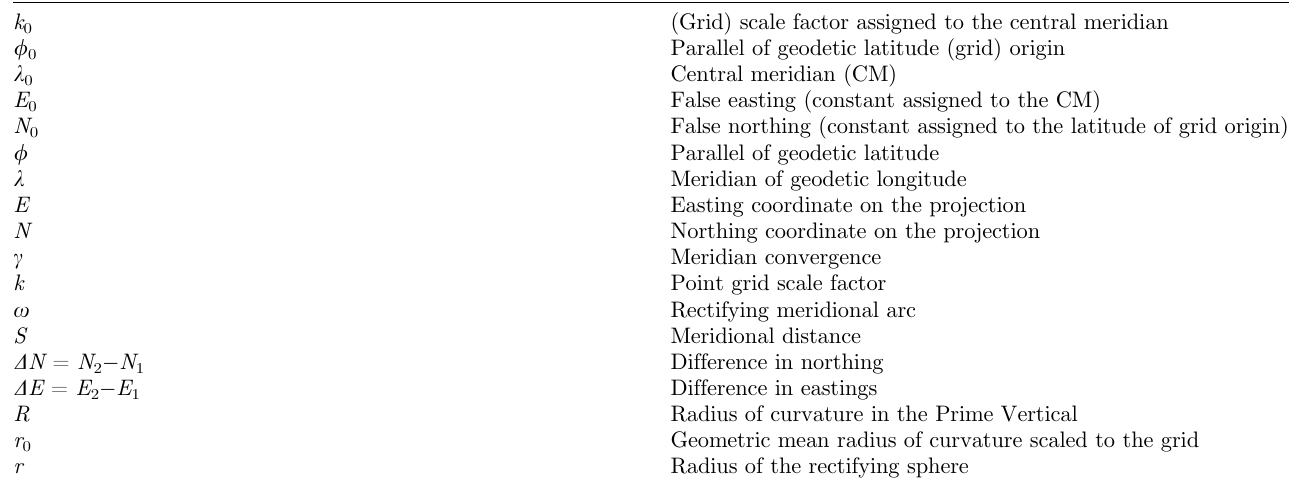
Table B-1. De fi nitions and symbols of